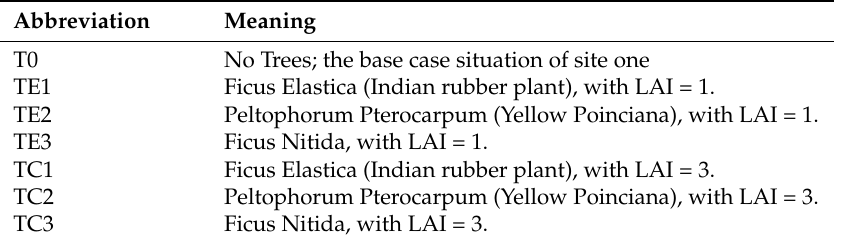
Table 1. Abbreviations used for